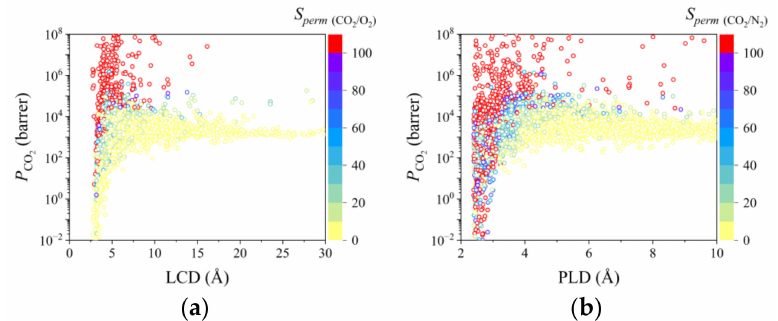
Figure 2. Relationship between LCD/PLD and permeance performance. ( a ) LCD– P CO (CO 2 /O 2 ) ; ( b ) PLD– P CO 2 – S perm (CO 2 /N 2 ) .